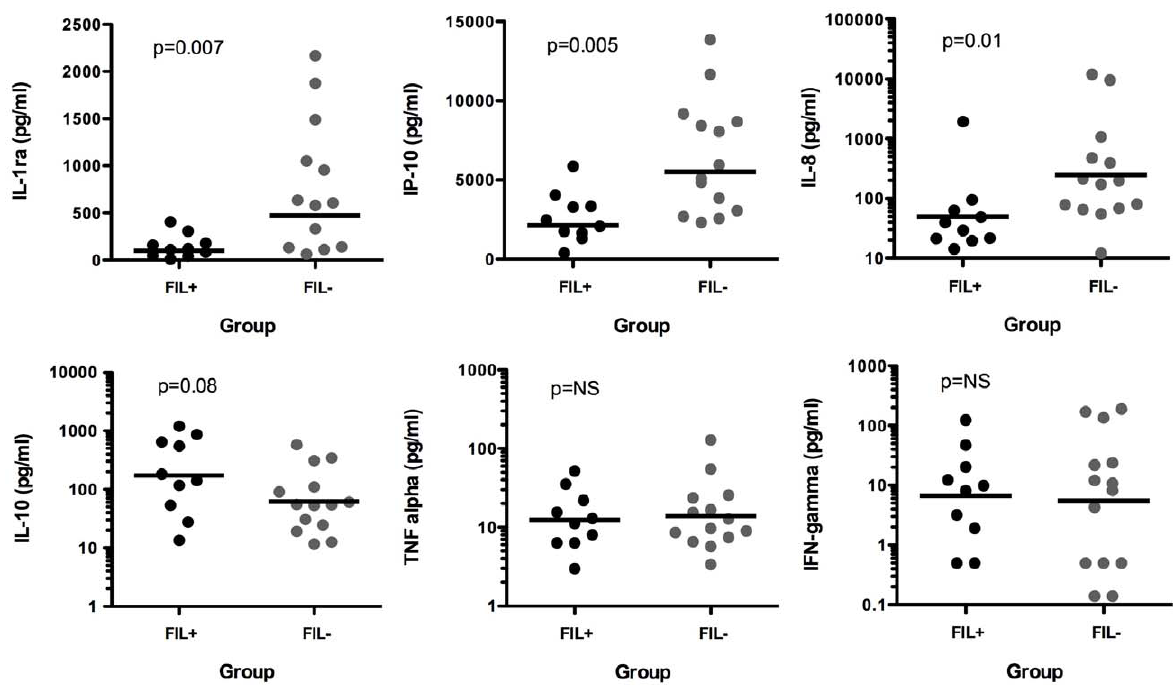
Figure 6. Plasma cytokine and chemokine levels at the time of acute malaria. The symbols represent individual values for FIL + (black circles) and FIL 2 (gray circles) subjects. The horizontal lines represent the GM values for the groups.